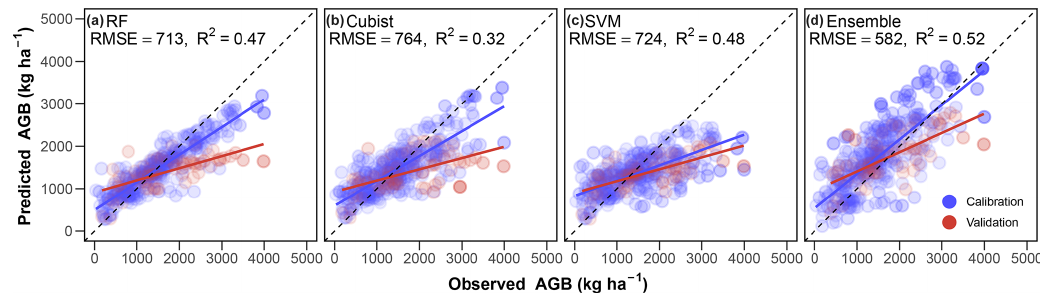
Figure 3. Performances of models to predict grassland aboveground biomass (AGB). (a) Random forest (RF); (b) cubist; (c) support vector machines (SVM); (d) , the ensemble model of (a) – (c) . For each individual model, 80% of the stratified samples of observations were used for model calibration, with the other 20% used for validation. R 2 and RMSE show the coefficient of determination and root-mean-square error of model validations. In model calibrations, the R 2 is 0.82, 0.66 and 0.43 for RF, cubist and SVM, respectively, and RMSE is 359, 460 and 579kgha − 1 for RF, cubist and SVM, respectively.